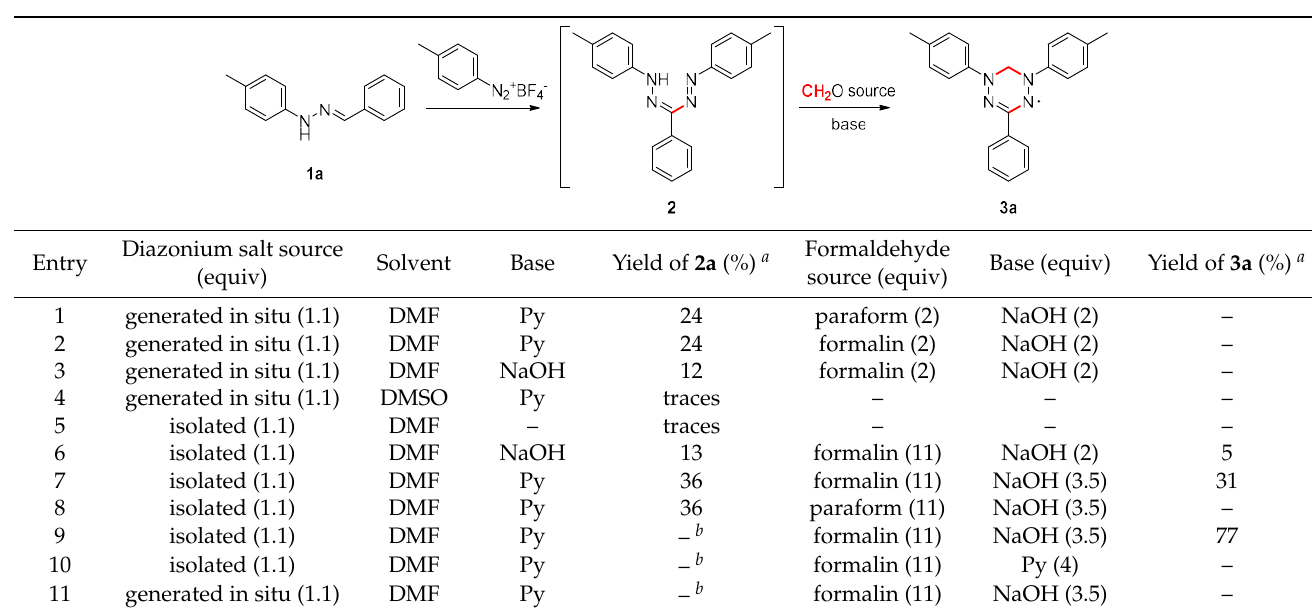
Table 1. Optimization of the reaction conditions.